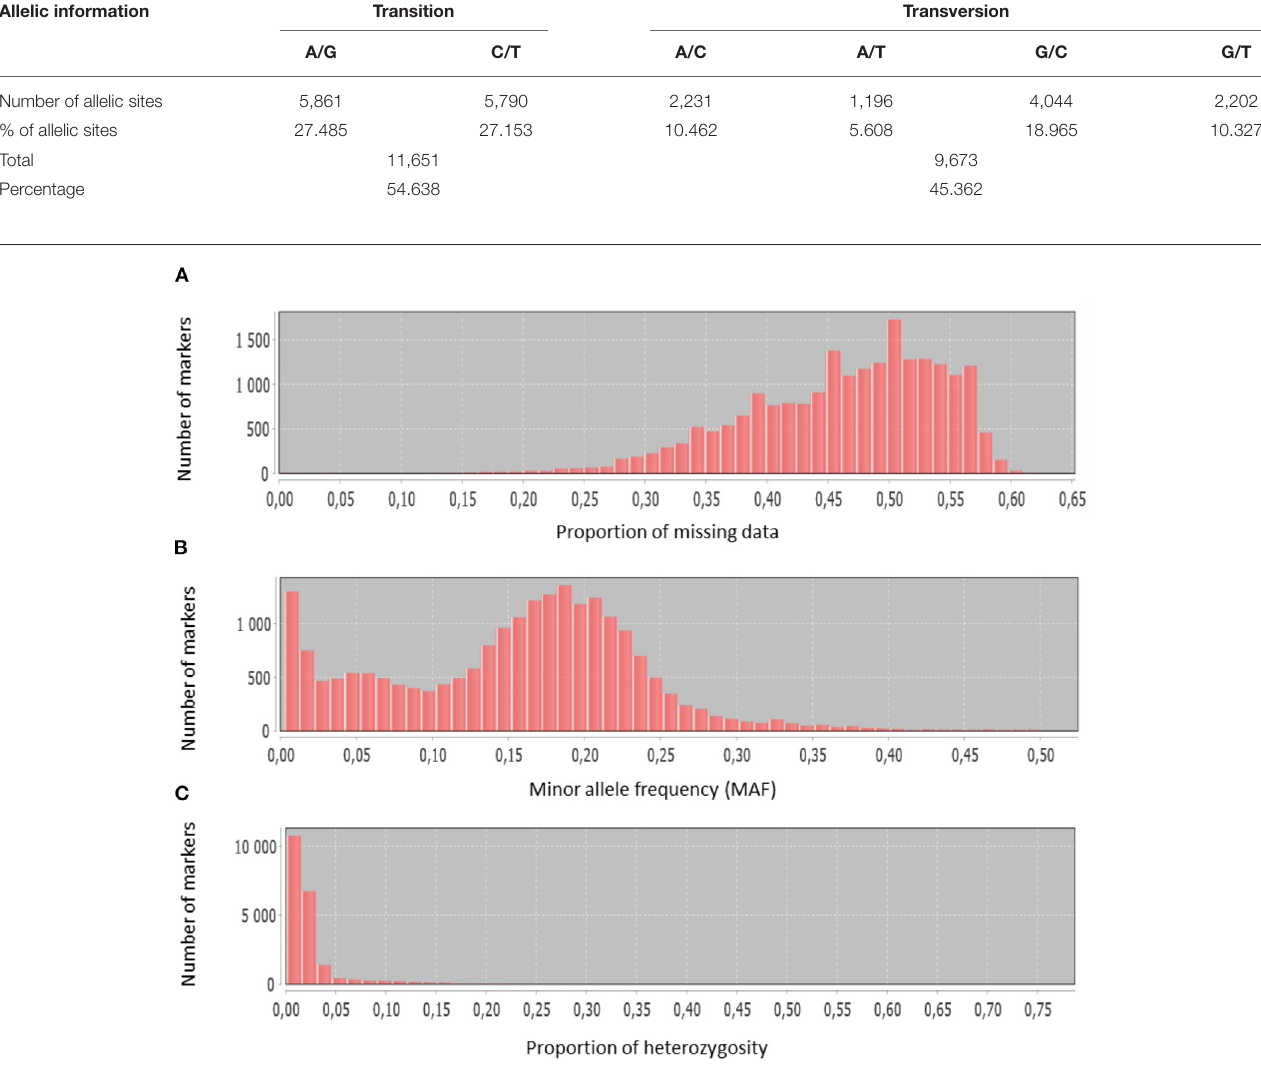
between cluster 2 and cluster 3. An intermediate Fst-value (0.69) was observed between cluster 1 and cluster 2. Moreover, the highest Fst-value (0.72) was detected between cluster 1 and cluster